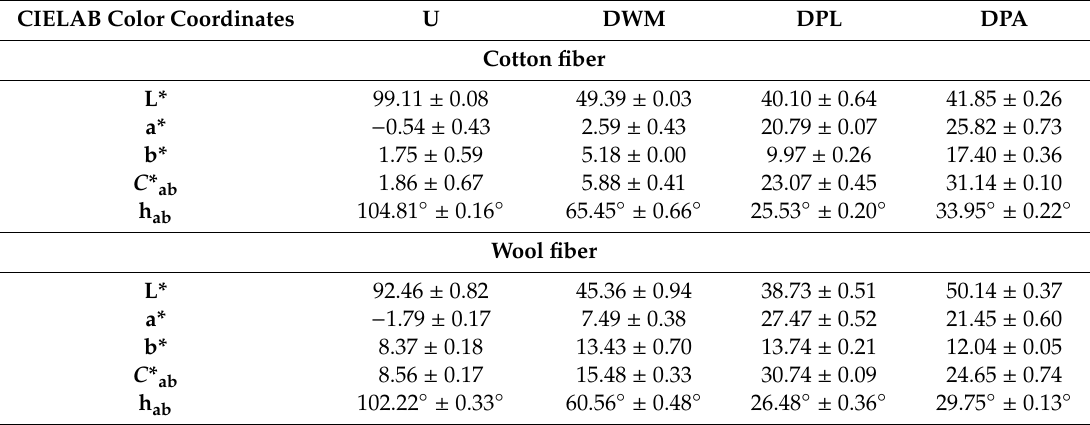
Table 2. Colorimetric data and the CIELAB color coordinate values (CIELAB units) of the cotton plant fibers and the wool animal fibers colored using the extracts of the peel of the fruits of Opuntia ficus-indica (L.)